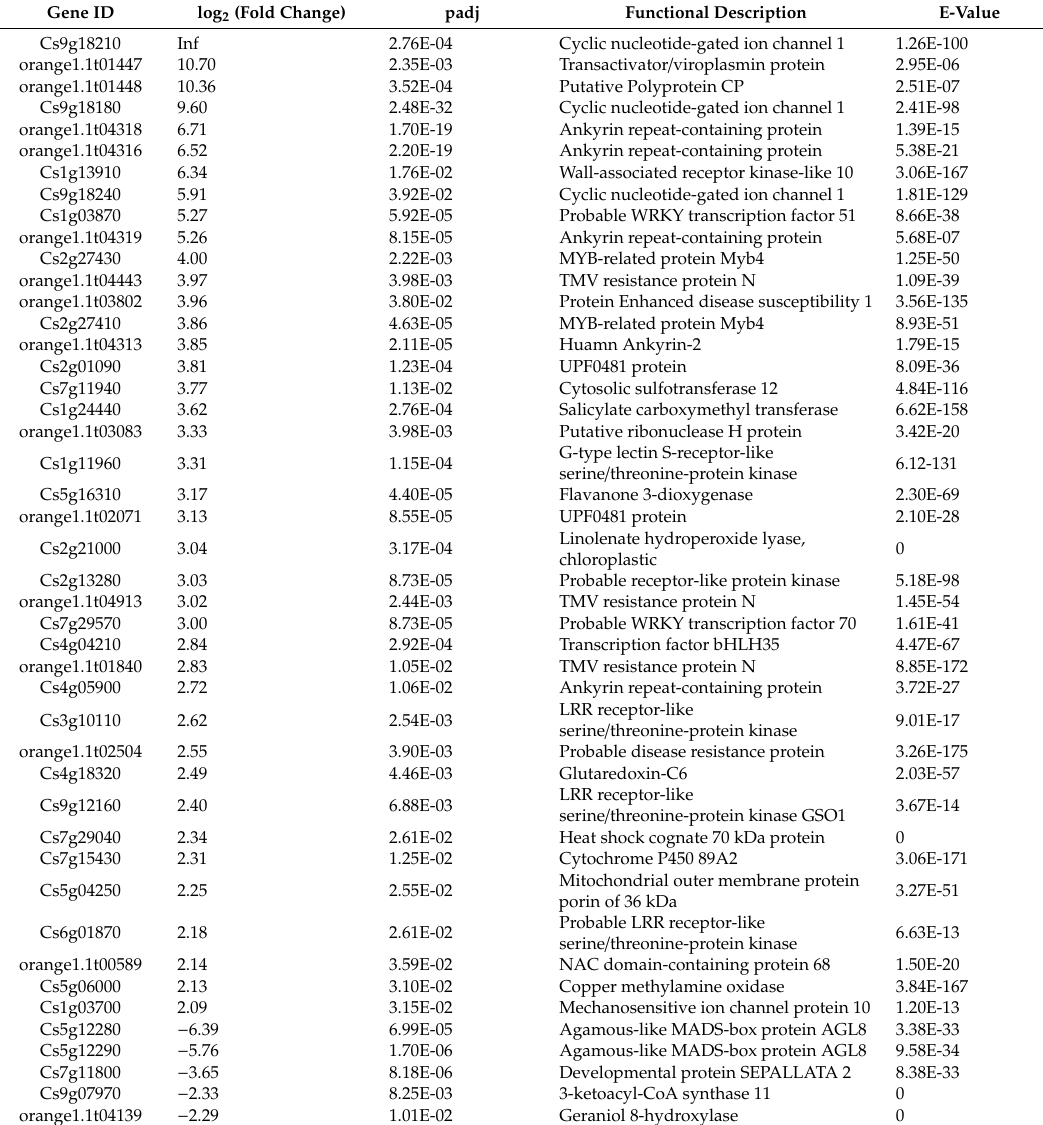
Table 2. List of all DEGs between the NPR1-2 transgenic line and control non-transgenic ‘Valencia’